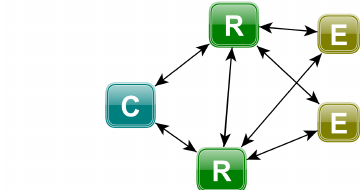
Figure 4. Simple layout of the connection of the transmission modules. © 2018 Mohammad Shakeri. Adapted from [28]; originally published under Creative Commons Attribution 3.0 license. Available from: